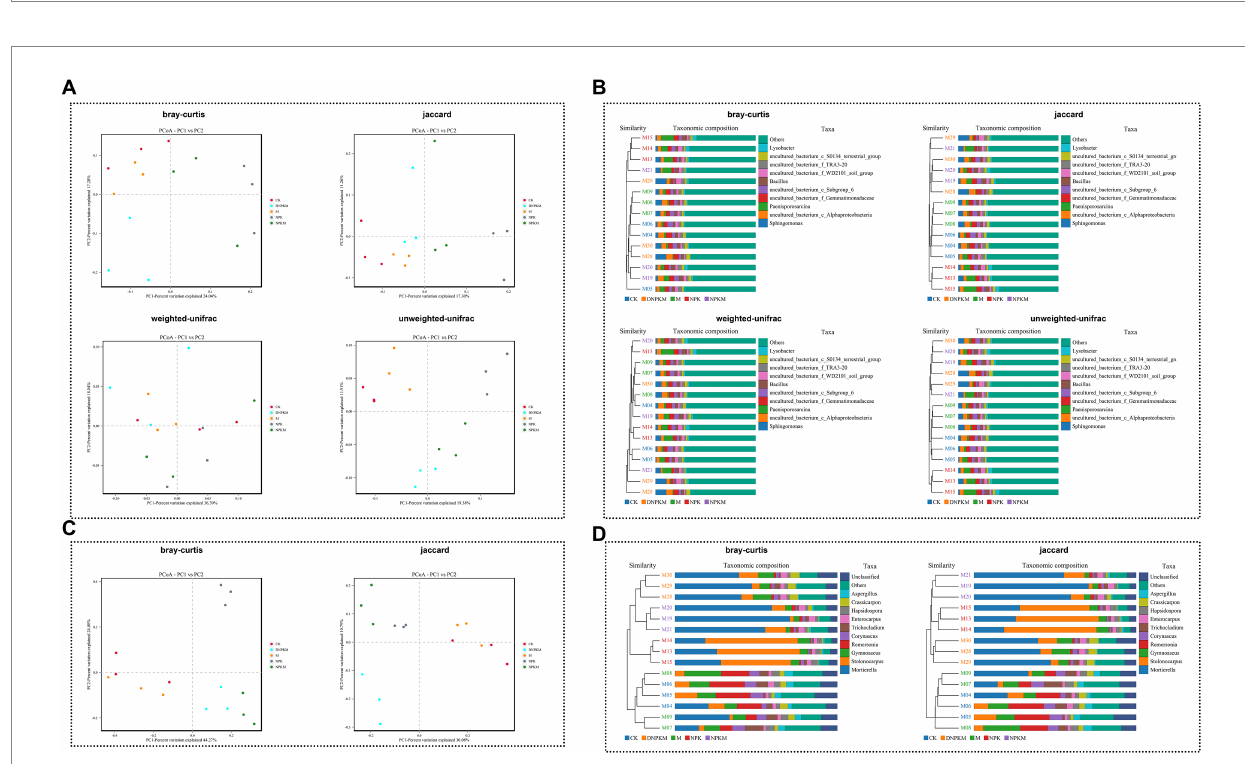
FIGURE 2 Effect of fertilizer strategies on the structure of soil microbial communities. (A,B) PCoA (A) and cluster analysis (B) of the bacterial community based on the bray-Curtis, Jaccard, weighted-unifrac, and unweighted-unifrac distance algorithm. (C,D) PCoA (A) and cluster analysis (B) of the fungal community based on the bray-Curtis and Jaccard distance